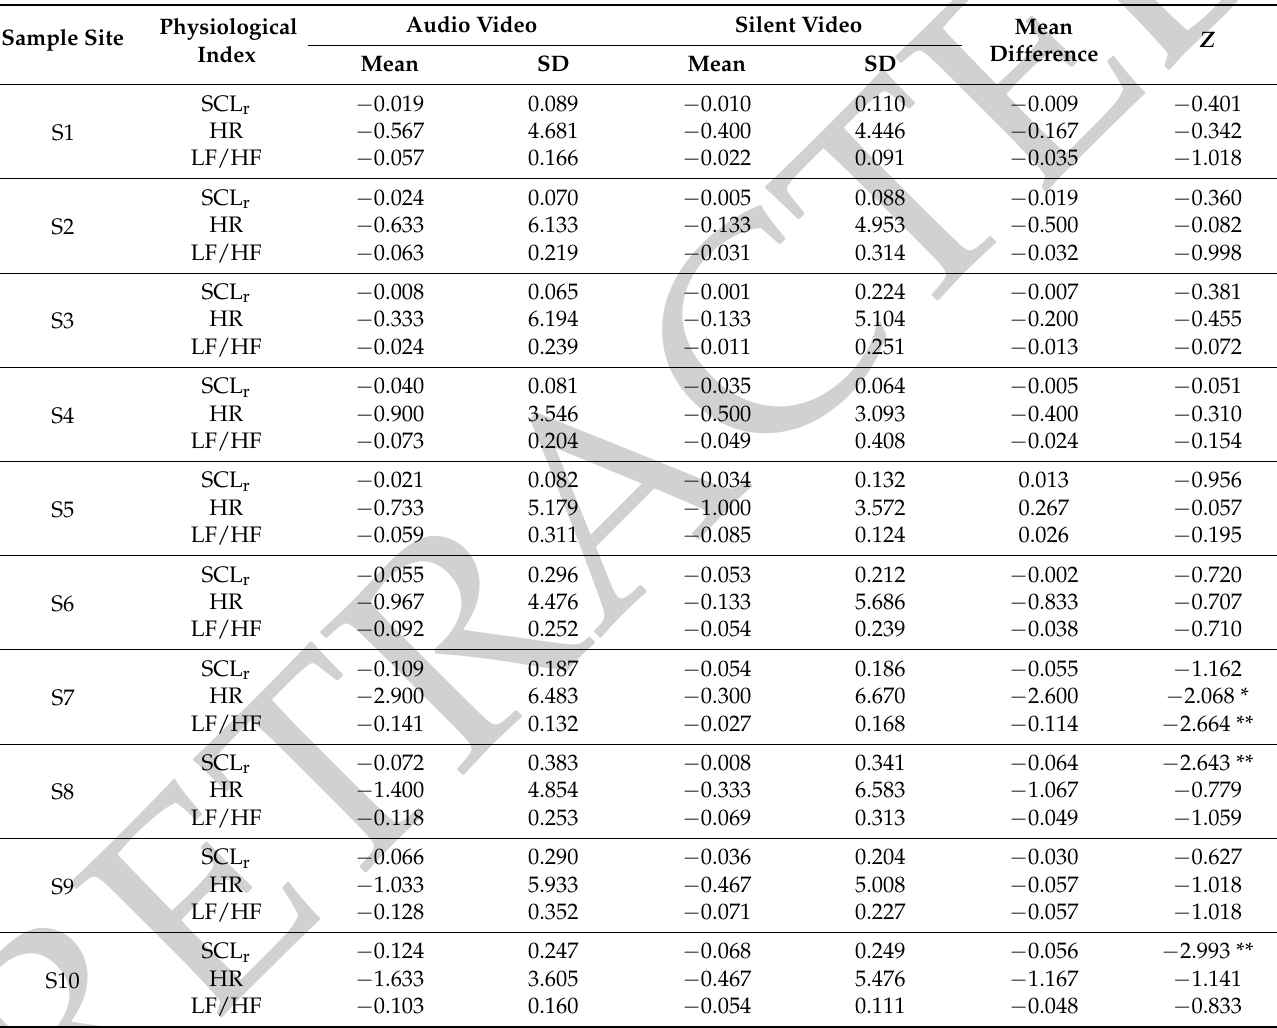
Table 4. Differences in relieving stress effects between silent video and audio